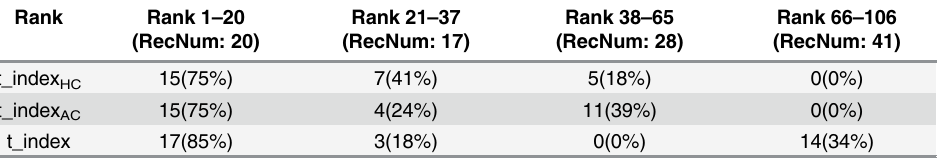
Table 5. Segmented counts of the 106 top-ranked authors based on